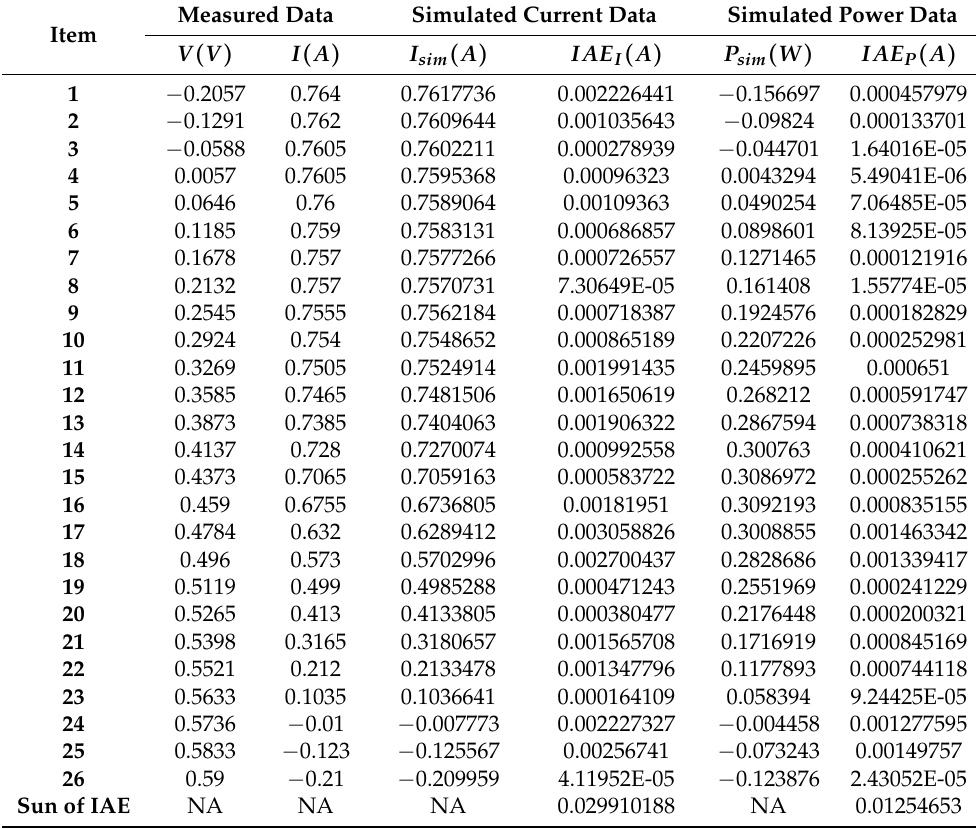
Table 8. IAE of MLCPA on